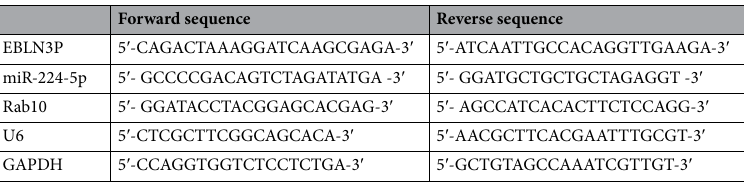
Table 1. Primer sequences for quantitative real-time